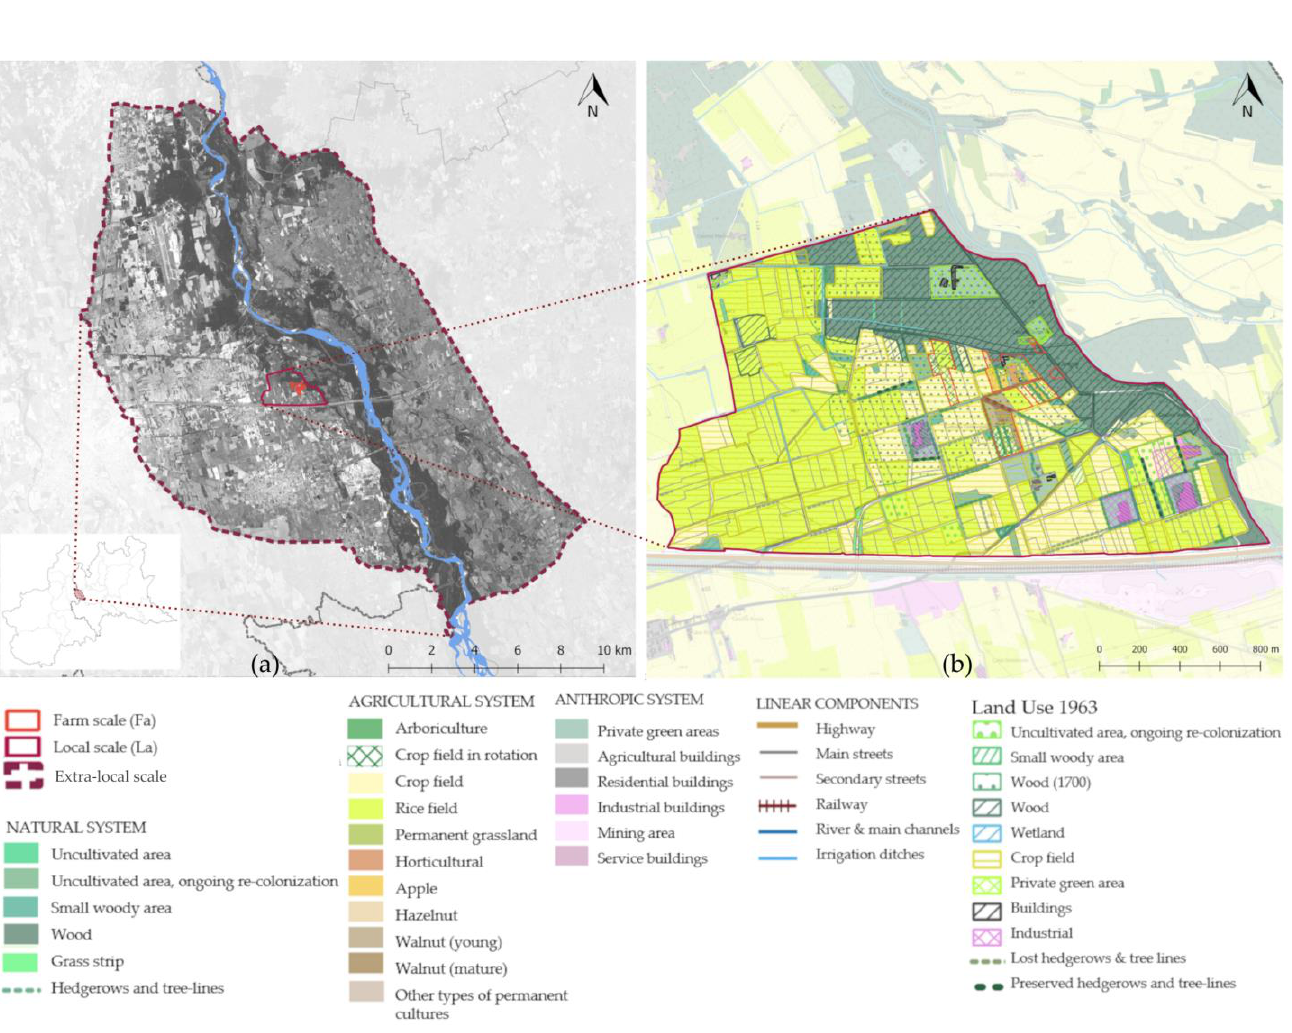
Figure 1. ( a ) Pilot farm location among the regional, extra-local, and local contexts, along the Ticino River basin; ( b ) land cover at local scale (LCP 2010, Piedmont region [85]), showing the current landscape patches and linear corridors (as used for landscape metrics computing), compared to historical traits.